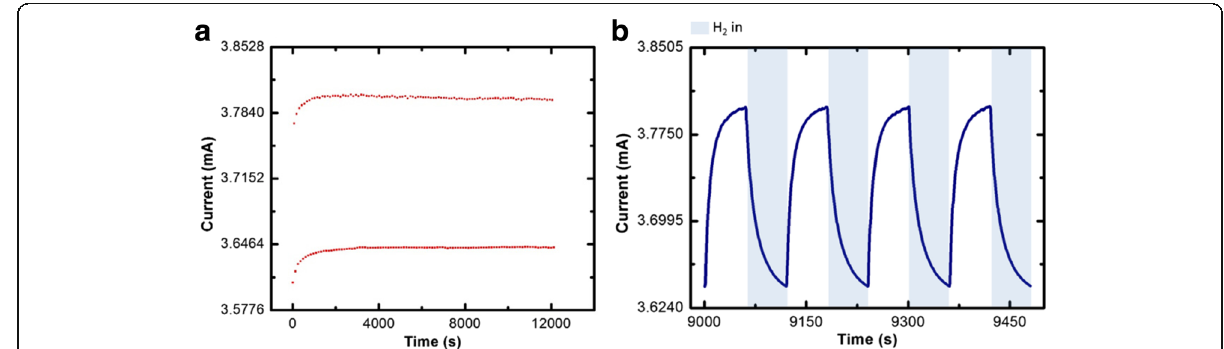
Fig. 2 Hydrogen gas sensing behaviour in the dark at 100 ° C. a Maximum and minimum point for 100 cycles. b Response of CuO NWs sensors toward hydrogen gas